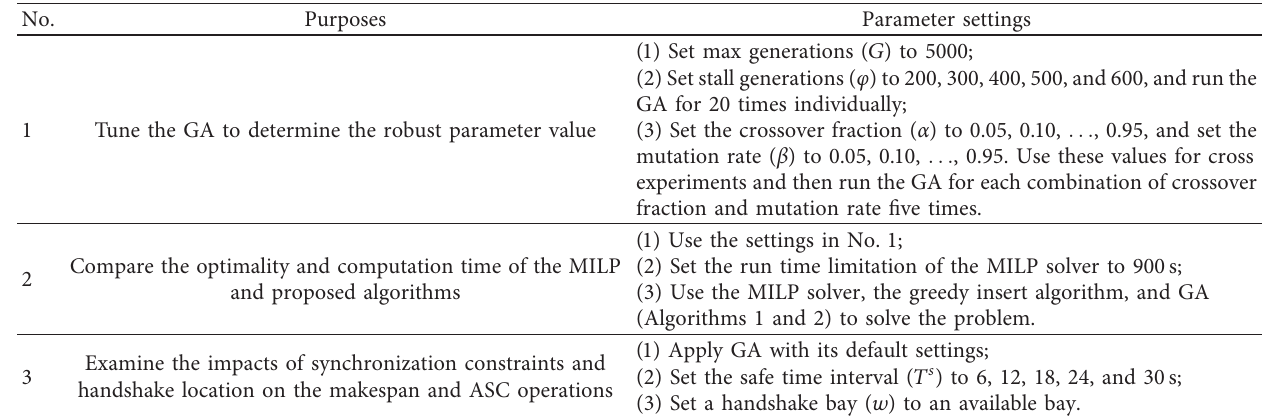
Table 3: Experimental settings.